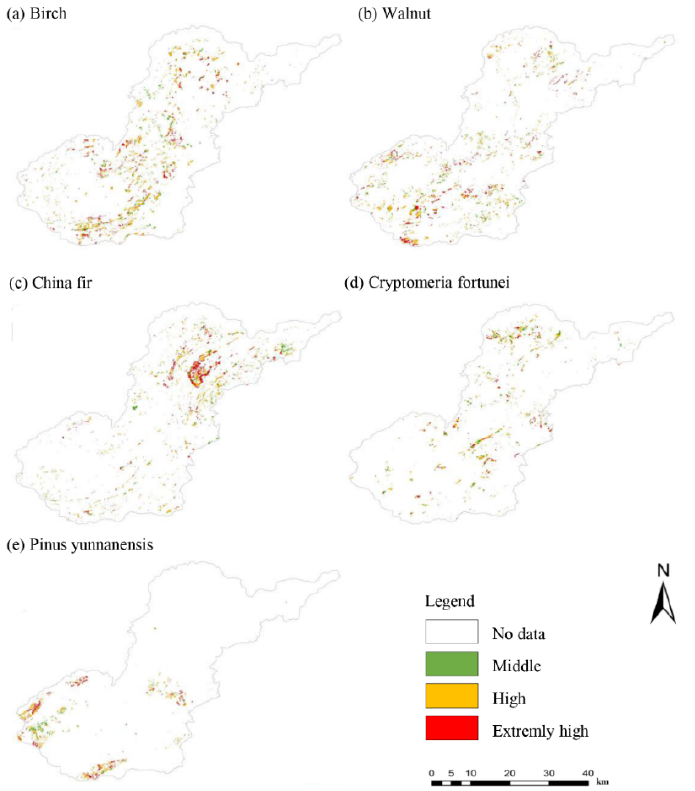
Figure 7. Spatial distribution map of landslide susceptibility of dominant tree species in Qixingguan District.